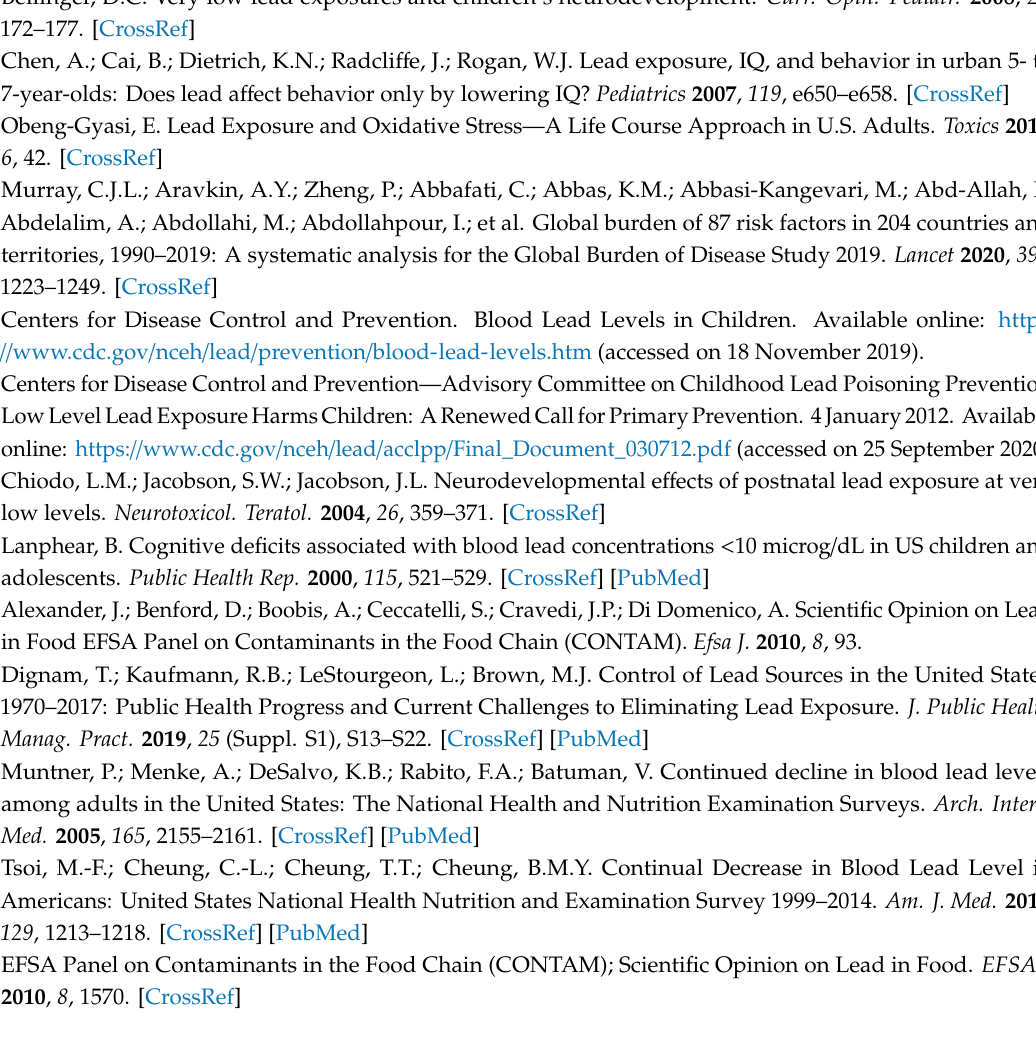
Table S1: Comparison of characteristics at age 1 year between children to assess di ff erences among included and excluded children at 1 year of age, Table S2: Bivariate analysis between sociodemographic factors and potential sources of lead in children at age 6 years ( N = 425), Table S3: Associations between sources of lead and socio-demographic factors. Table S4: Sensitivity analysis—Multivariable analyses identifying potential sources